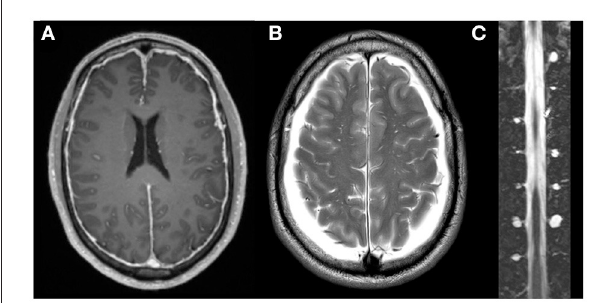
FIGURE 1 | Imaging of a patient with SIH symptoms without evidence of CSF leakage or CSF venous fistula. A 68-year-old male patient exhibiting classic SIH symptoms with typical cranial imaging findings, such as dural enhancement (A) and bilateral subdural hygroma (B) and no evidence of CSF leakage or CSF venous fistula despite repeated diagnostic work-up. Spinal MRI revealed a large number of prominent meningeal diverticula (C) . FIGURE 2 | Pressure-volume curve of the craniospinal compartment. Pressure